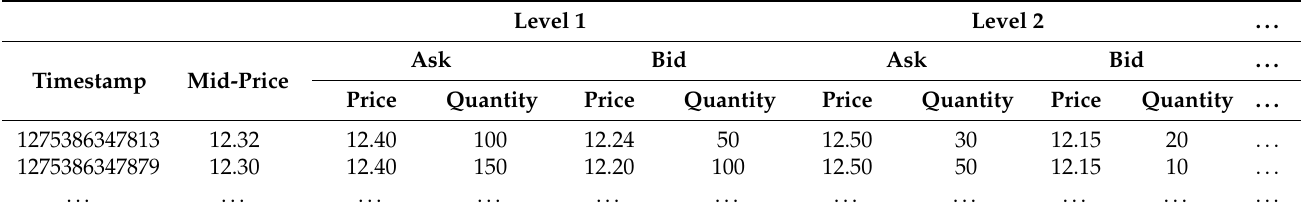
Table 1. Limit Order Book dataset illustrative